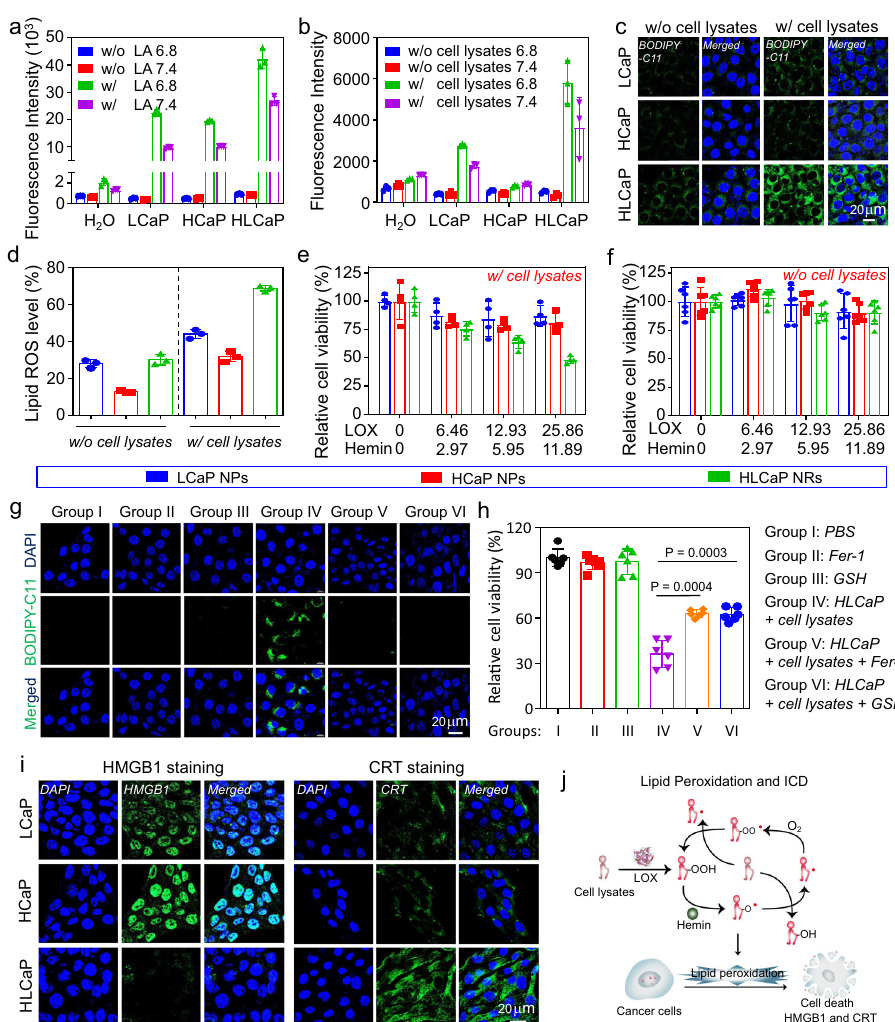
Fig. 3 pH-responsive catalytic capacity and in vitro therapeutic ef fi cacy of HLCaP NRs. a , b pH-responsive lipid peroxidation generation capacities of LCaP NPs, HCaP NPs, and HLCaP NRs incubated with linoleic acid ( a ) or cell lysates ( b ) at pH 6.8 and 7.4, respectively. c , d Confocal images ( c ) and fl ow cytometric analysis ( d ) of 4T1 cells incubated with HCaP NPs, LCaP NPs, and HLCaP NRs in the presence (w/) or absence (w/o) of cancer cell lysates, followed by being stained with lipid peroxidation probe of BODIPY-C11. e , f Relative cell viabilities of 4T1 cells incubated with HCaP NPs, LCaP NPs, and HLCaP NRs in the presence ( e ) or absence ( f ) of cancer cell lysates for 24 h before being determined by MTT assay. g , h Confocal imaging of intracellular lipid peroxidation ( g ) and relative cell viabilities ( h ) of 4T1 cells post various treatments as indicated. i Confocal images of 4T1 cells incubated with HCaP NPs, LCaP NPs, and HLCaP NRs in the presence of cancer cell lysates, followed by being stained with HMGB1 and CRT antibodies, respectively. j Schematic illustration of HLCaP NRs mediated propagation of lipid peroxidation and subsequent immunogenic cell death (ICD) induced in the presence of cell